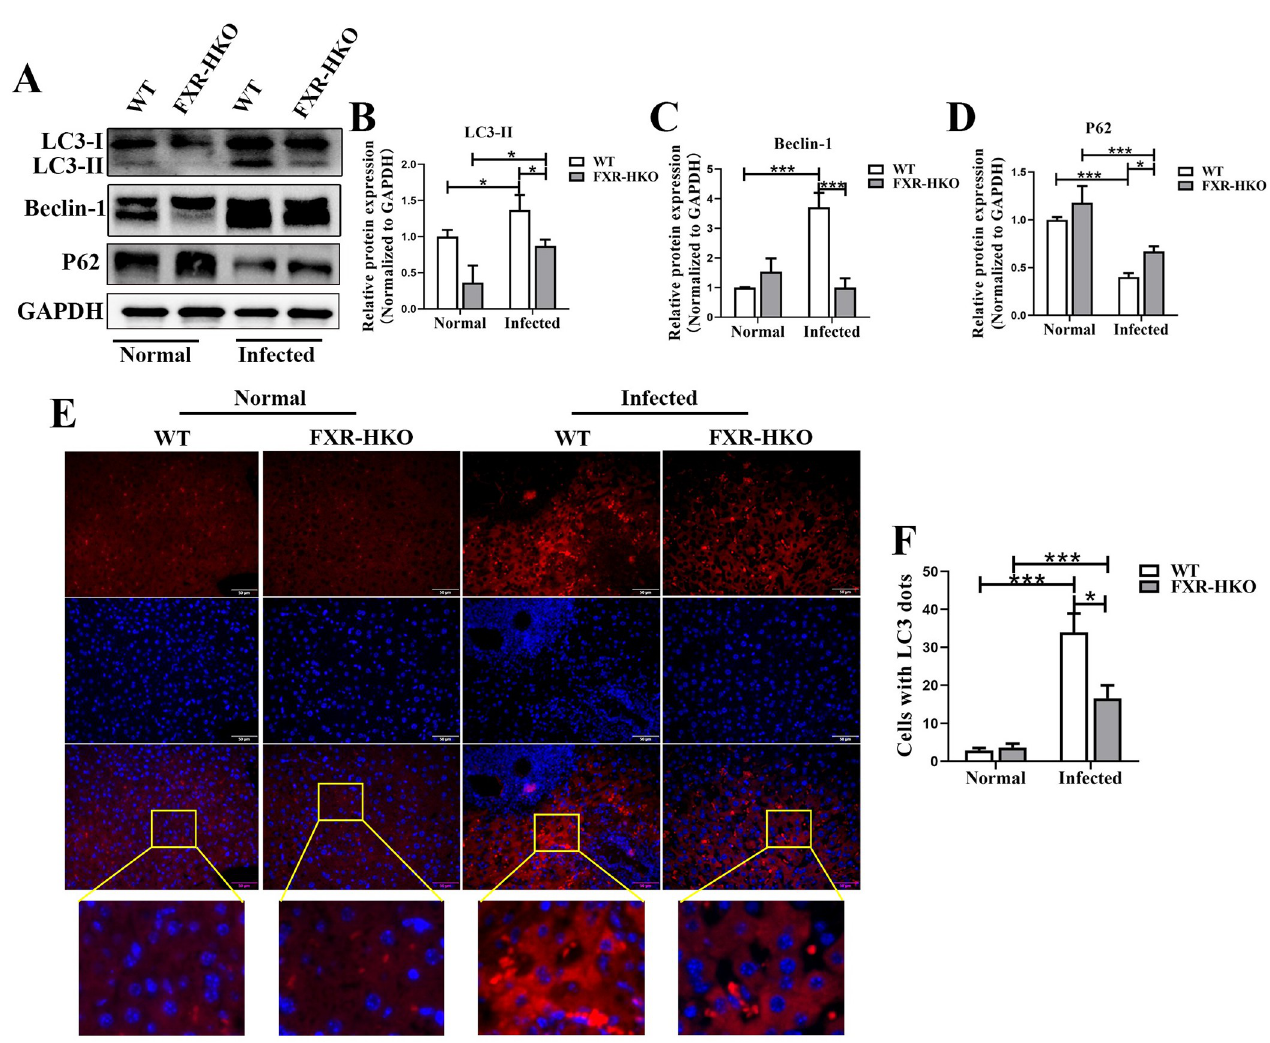
Fig 6. Autophagy is inhibited in FXR-deficient mice with S . japonicum infection. (A) Hepatic LC3, Beclin-1, and P62 in the mice of each group were measured by western blot. The densitometry analysis of LC3 (B), Beclin-1 (C), and P62 (D) was screened and measured by Image Pro Plus 6.0 software. (E) Immunofluorescene analysis of LC3 in liver tissue from each group, and the representative images were shown. (F) Counts of cells with LC3 dots were analyzed in mice for each group. Data are expressed as mean ± SEM. � P < 0.05, ��� P < 0.001.